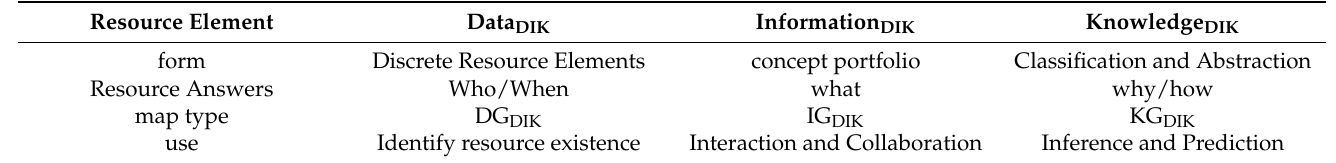
Table 3. Explanation of medical resource